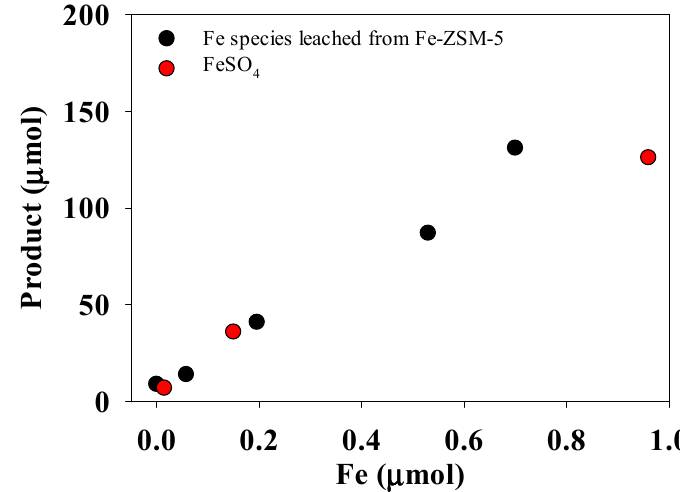
Figure 3. Total product yield as a function of the amount of Fe species in the homogeneous Fe catalyst system or in the liquid for the heterogeneous catalyst system with Fe-ZSM-5. All data were taken from Tables S6, S9, and S10.